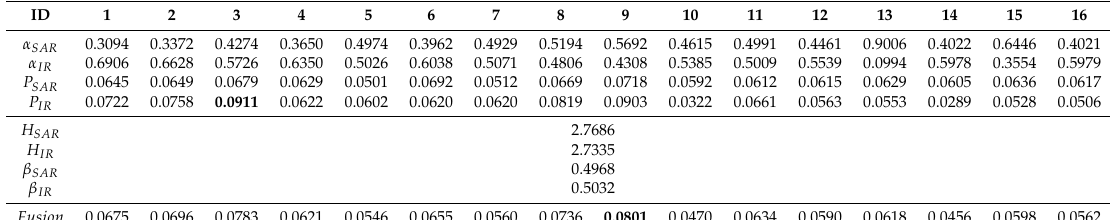
Figure 9. Effect of the offline weights ( α SAR , α IR ) in SAR-IR sensor fusion. Table 1. Details of the recognition improvement by the offline